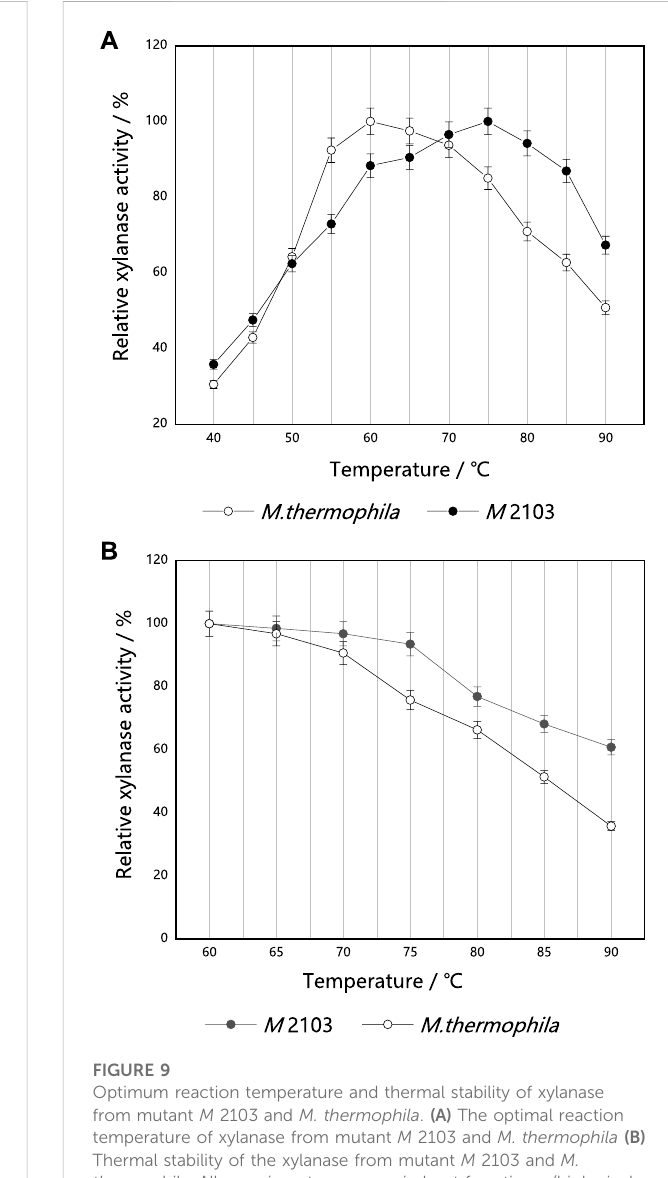
respectively. After being placed at 4 ° C for 36 h, the xylanase activity of M 2103 was compared with that of the untreated crude enzyme solution (Figure 8B). At a pH of 11.0, the xylanase activity of M